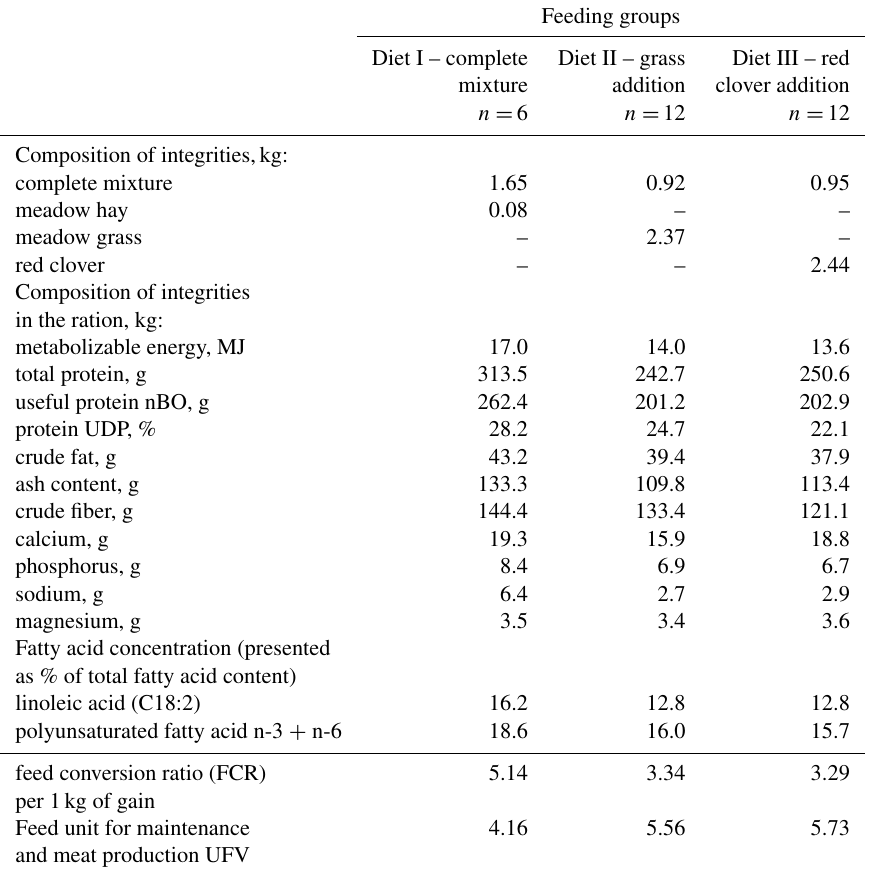
Table 1. The composition and nutritional value of each diet and the exact feed conversion ratios.